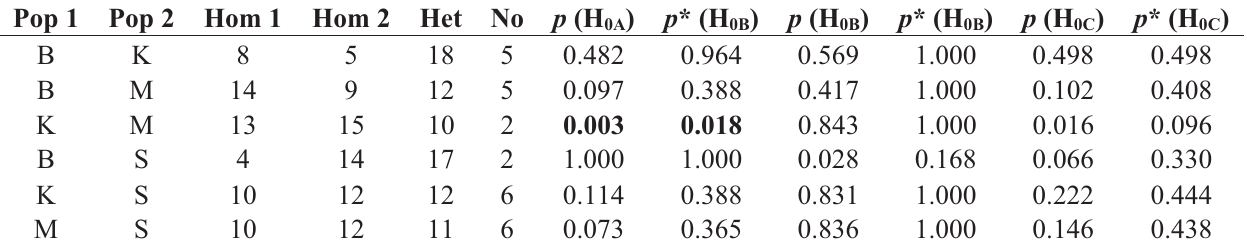
Table 6. Multiple choice experiment (2 males/2 females). The four categories were: Hom 1: Homogeneous for population 1 (Hom 1), homogeneous for population 2 (Hom 2), heterogeneous (Het), and no mating (no). For each experiment, we tested three hypotheses (H 0A : equal homogeneous and heterogeneous crosses, H 0B : equal homogeneous crosses of each kind, H 0C : random mating, which means 25% of each homogeneous cross and 50% heterogeneous